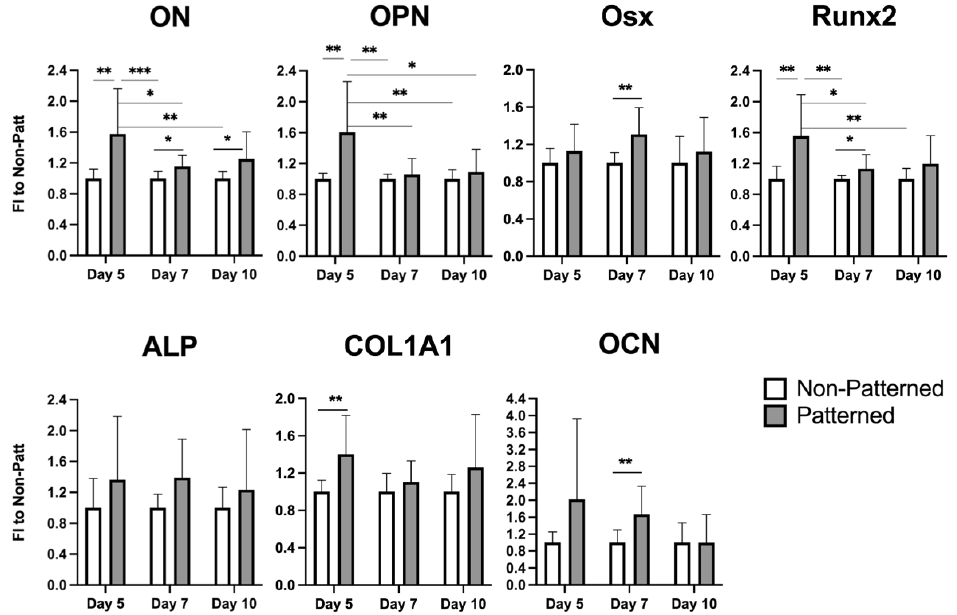
Figure 6. Expression of osteogenic genes on days 5, 7, and 10 in patterned hydrogels cultured in osteogenic degradation-free media with aprotinin (OMA). Gels with randomly encapsulated cells (non-patterned) served as a negative control. *, **, and *** represent p ≤ 0.05, p ≤ 0.01, and p ≤ 0.001, respectively.